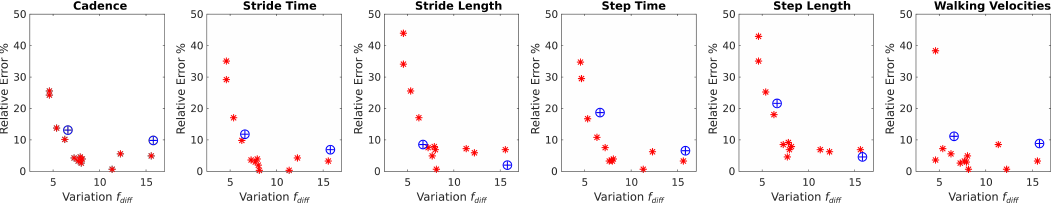
Figure 8. Relative error of the i-Walker parameters compared with the Optotrak system in challenged volunteers ( ⊕ ) and healthy volunteers ( ∗